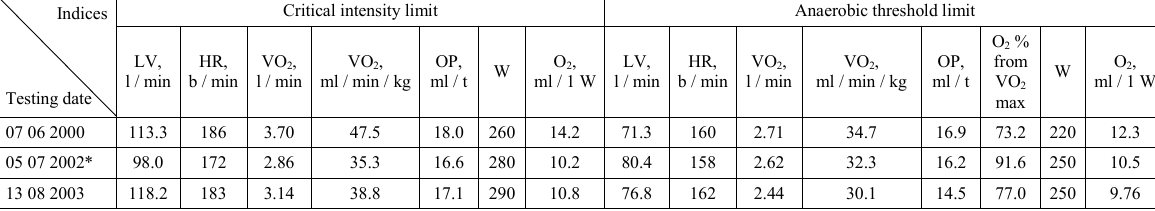
Fig. 1. Dynamics of muscle (A) and fat